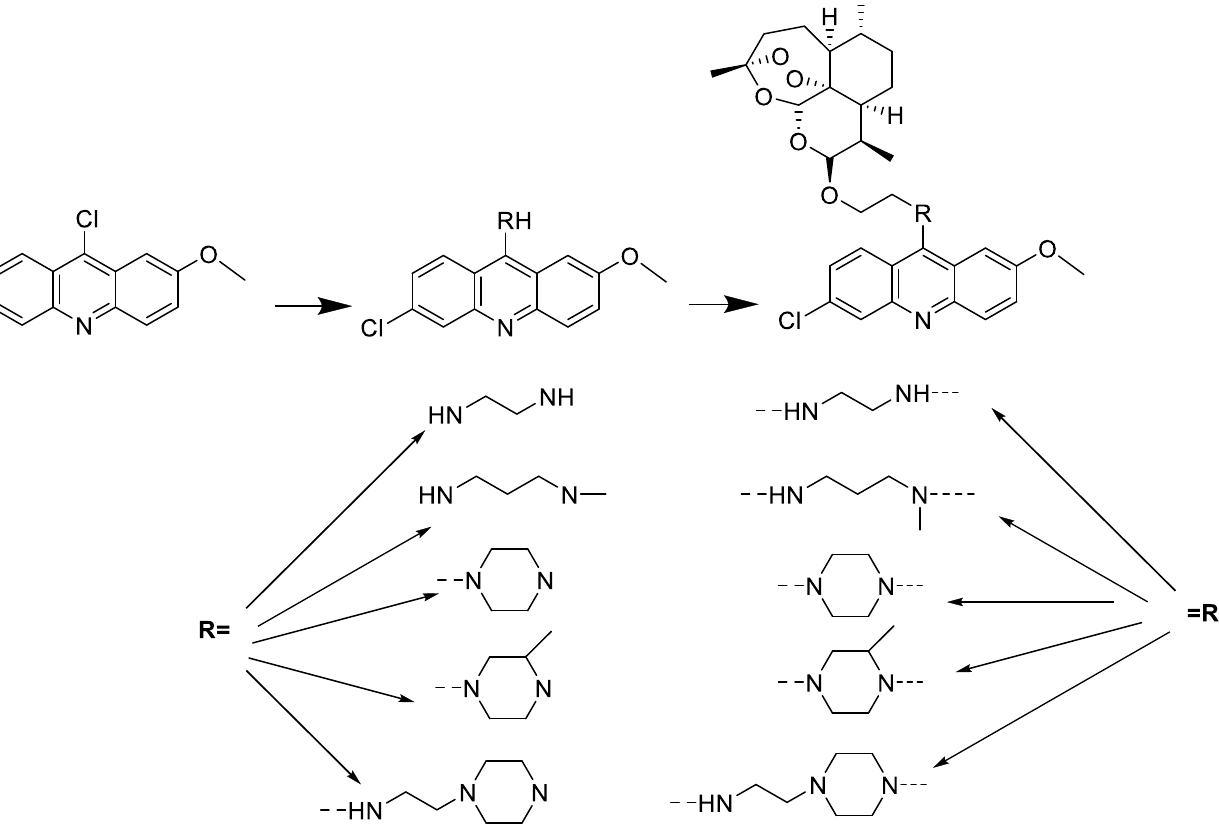
Figure 4. Multi-step synthesis of artemisinin – acridine hybrids and their derivatives. Table 2. 9-aminoacridine as an anti-tumour agent.